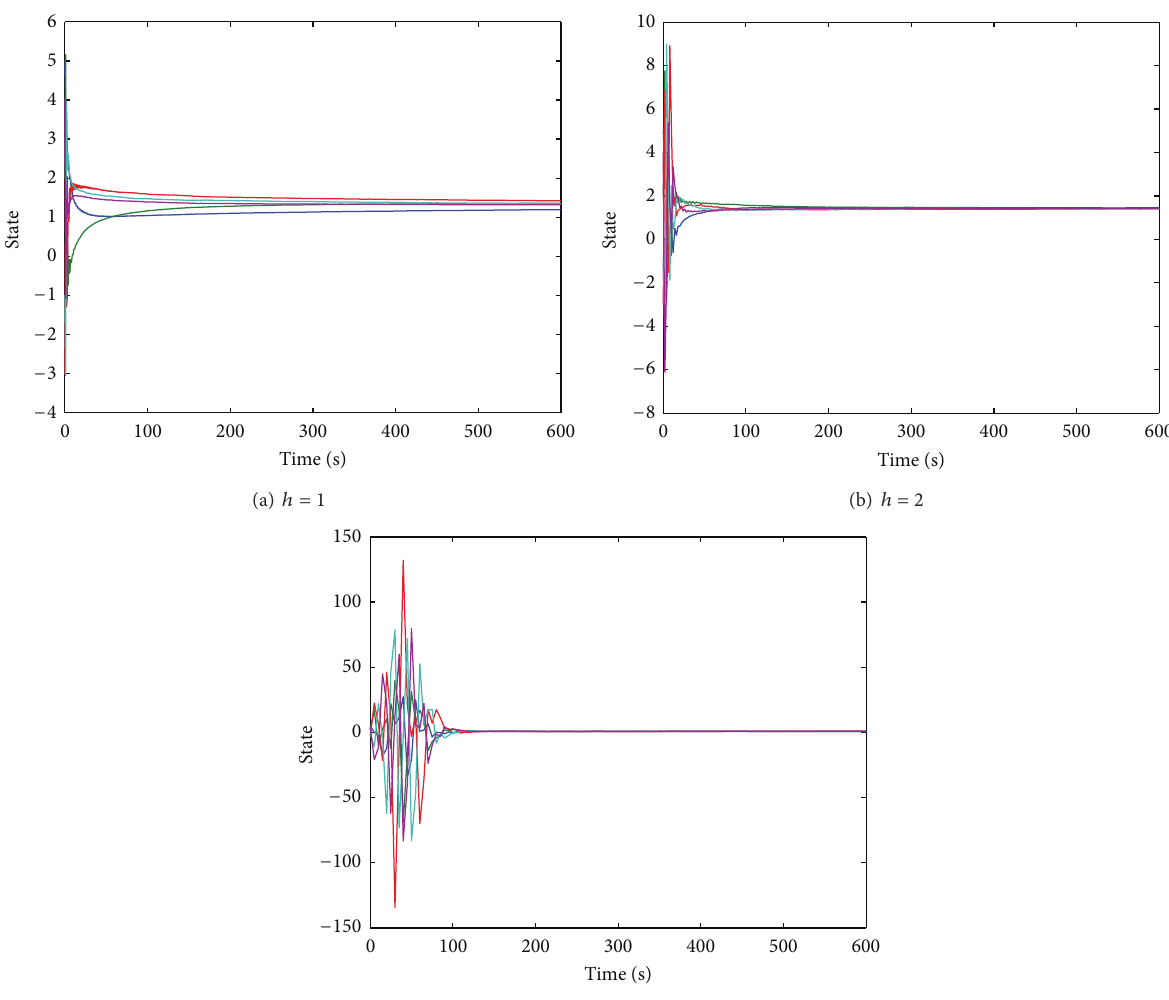
Figure 5: State trajectories under different sampling periods with noisy measurements and time-varying topology.